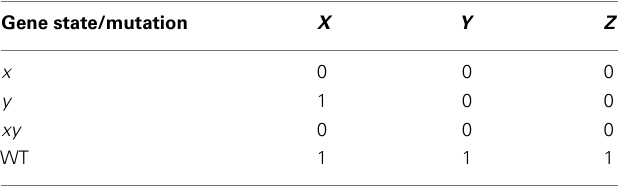
Table 1 | Results obtained from epistasis analysis of examples in Figure 3.